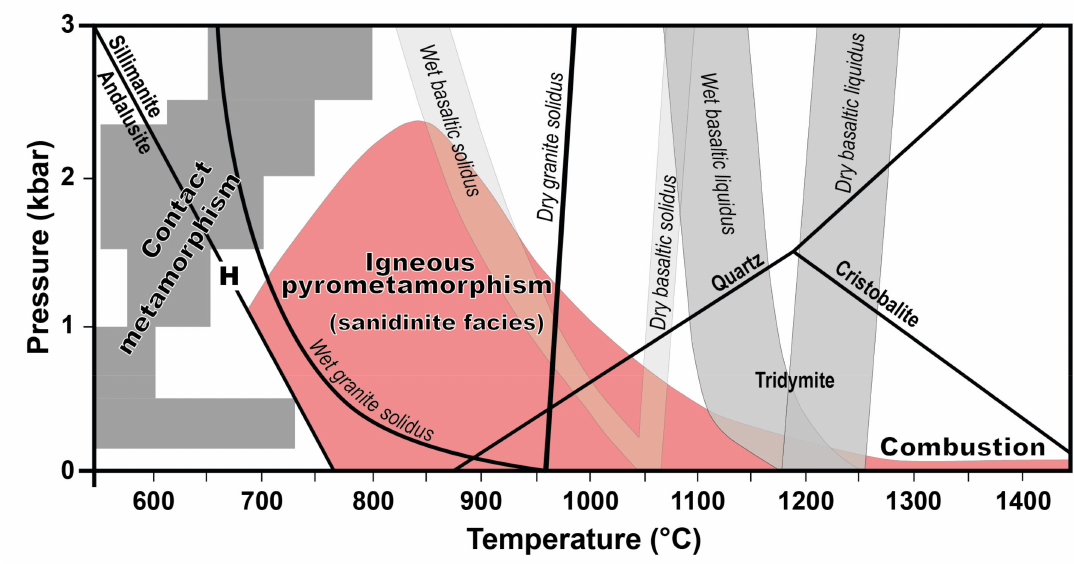
Figure 1. The Petrogenetic Grid at low pressure (P < 3 kbar) showing a relationship of igneous pyrometamorphism (sanidi- nite facies rocks) with lower temperature contact metamorphism (modified from [1]). P–T estimates of contact aureole rocks are from Barton et al. [3], wet/dry basalt solidus of various basalt compositions after Yoder and Tilley [4], wet/dry granite solidus from Tuttle and Bowen [5], andalusite/sillimanite transition (H) from Holdaway [6], quartz/tridymite/cristobalite inversion curves from Kennedy et al. [7] and Ostrovsky